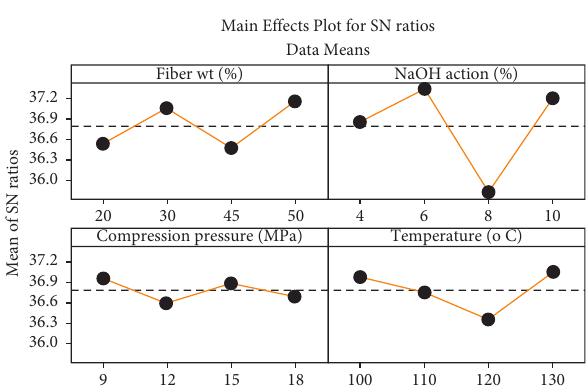
Figure 6: Main effect plot for S/N ratio to flexural strength.